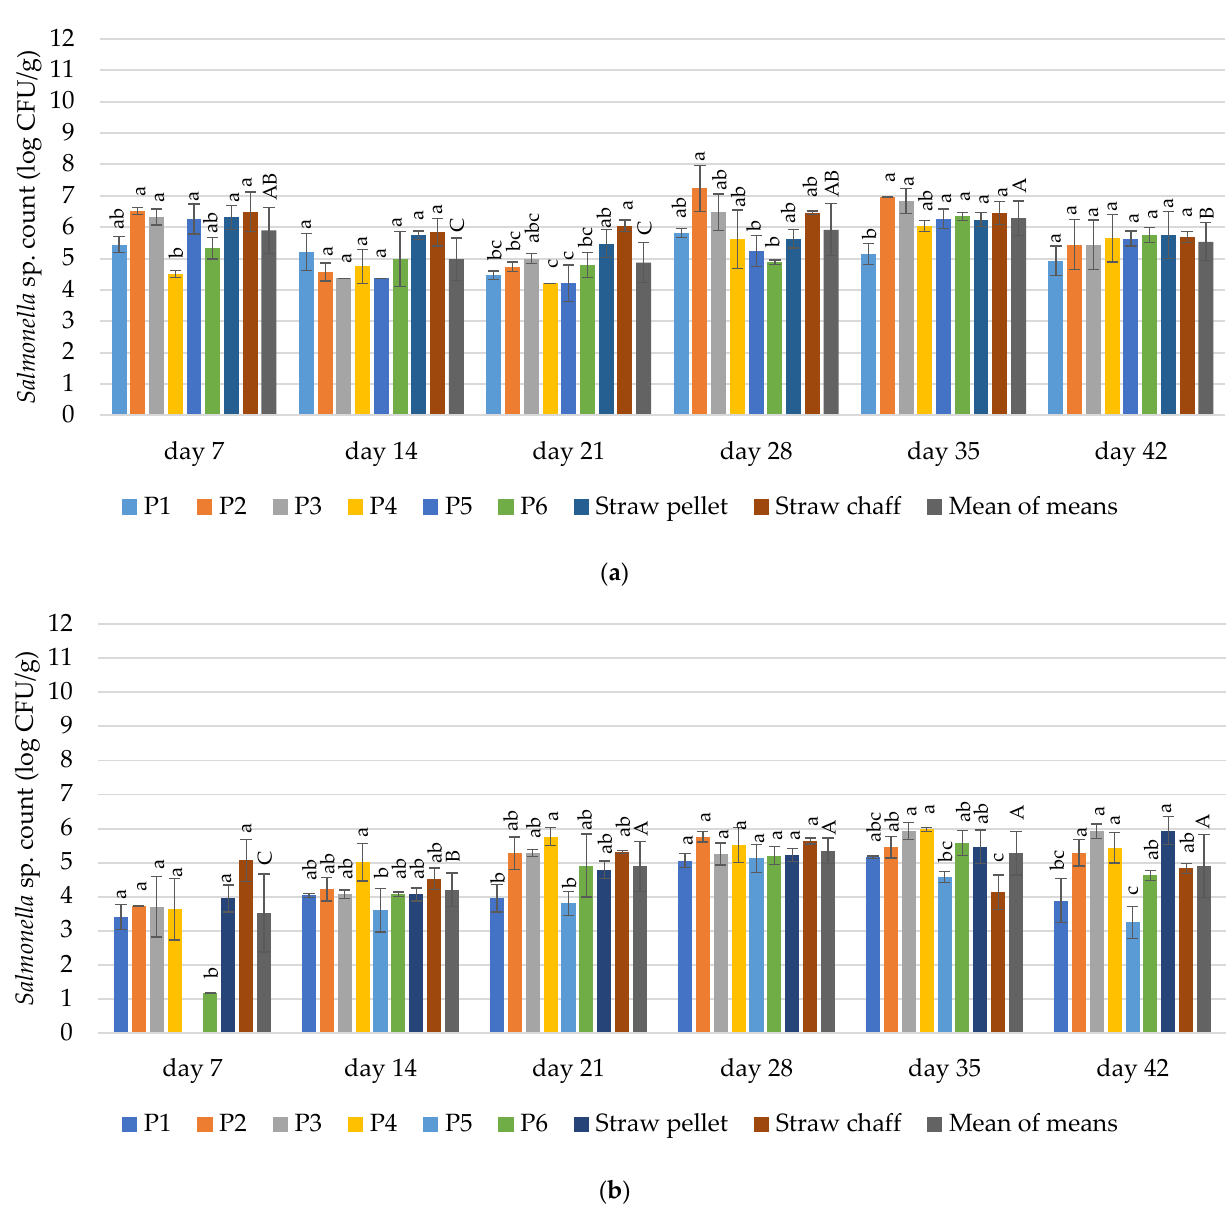
Figure 7. Changes in the count of microorganisms of Salmonella sp. in the tested bedding materials: ( a ) 1st experimental cycle; ( b ) 2nd experimental cycle. All values are means of three independent replicates ± SD, except the last bars for each day, which are the means-of-means. For each day, means with a common lowercase letter are not significantly different by the Tukey test at the 5% level of significance. For different days, means-of-means with a common uppercase letter are not significantly different by the Tukey test at the 5% level of significance. Pairwise comparisons between materials are presented only for observations from the same day. Pairwise comparisons between days are presented only for means-of-means. No pairwise comparisons between cycles are presented.